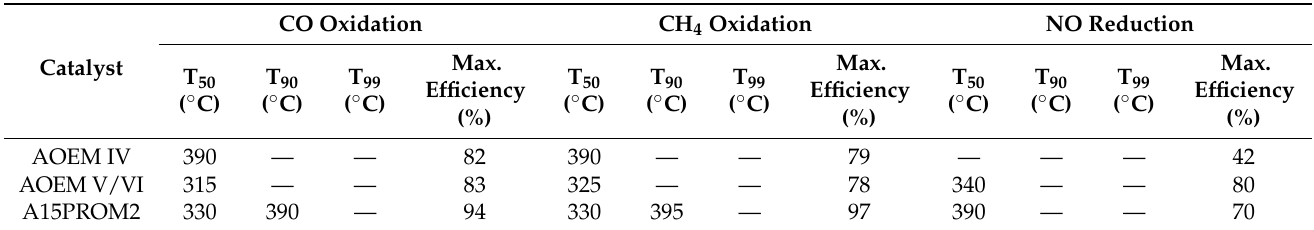
Table 9. Comparison of aged tested catalysts AOEM IV, AOEM V/VI and 15PROM2 under rich-burn conditions ( λ = 0.99).